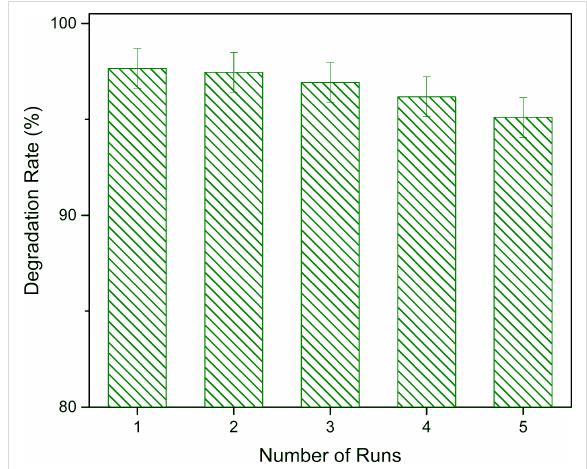
Figure 2: The cycle usage of the CZO-4 photocatalyst under opti- mized conditions in 2 h.